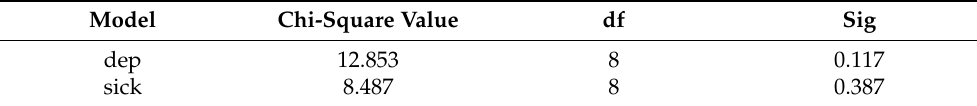
Table 4. Hosmer and Lemeshow